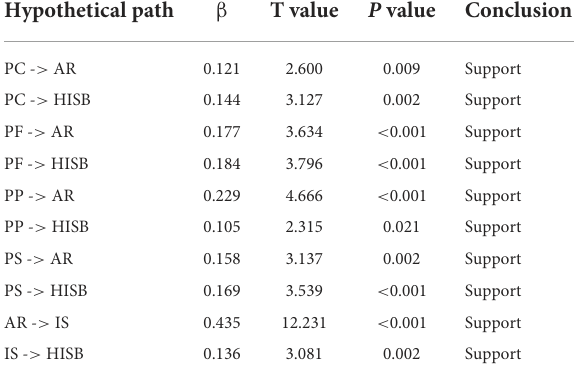
TABLE 9 Weights of first-order constructs on information quality second-order construct (examining H1). Hypothetical